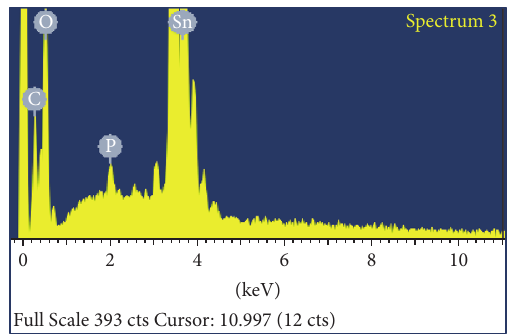
Figure 5: EDX spectrum of SnO 2 @ vinyl-phosphonic acid (S4).